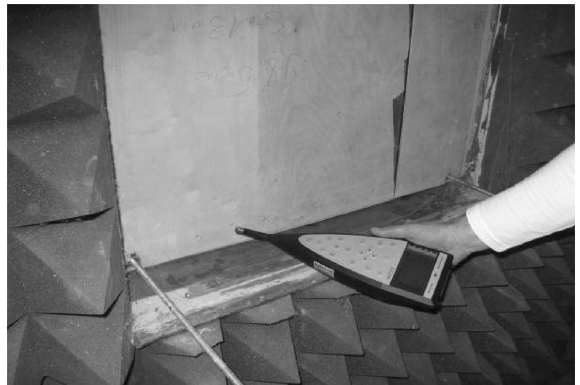
Fig. 2. Checking noise emission through spaces that emerged in the structure